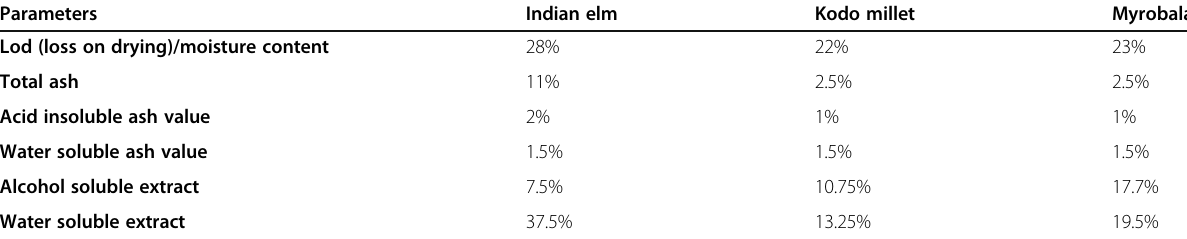
Table 4 Physico-chemical investigation of extract Parameters